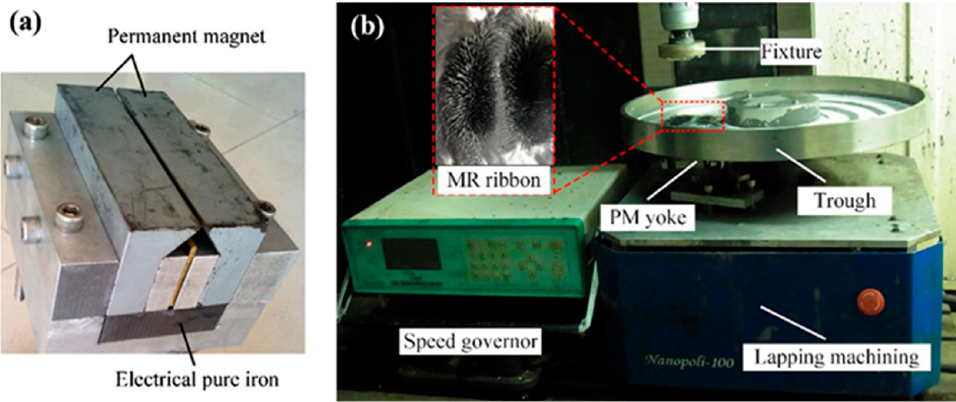
Figure 9. Experimental setup of magnetorheological finishing of zirconia ceramics (a) permanent magnetic yoke and (b) experimental setup, reused with permission from Elsevier [61].